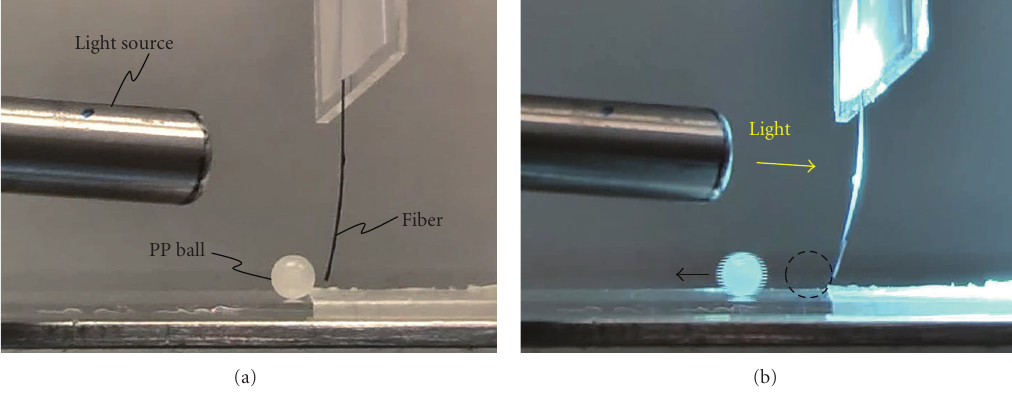
Figure 6: Photos demonstrating photo to mechanical energy conversion using a PAA/MB fiber and a PP ball (a) before and (b) after